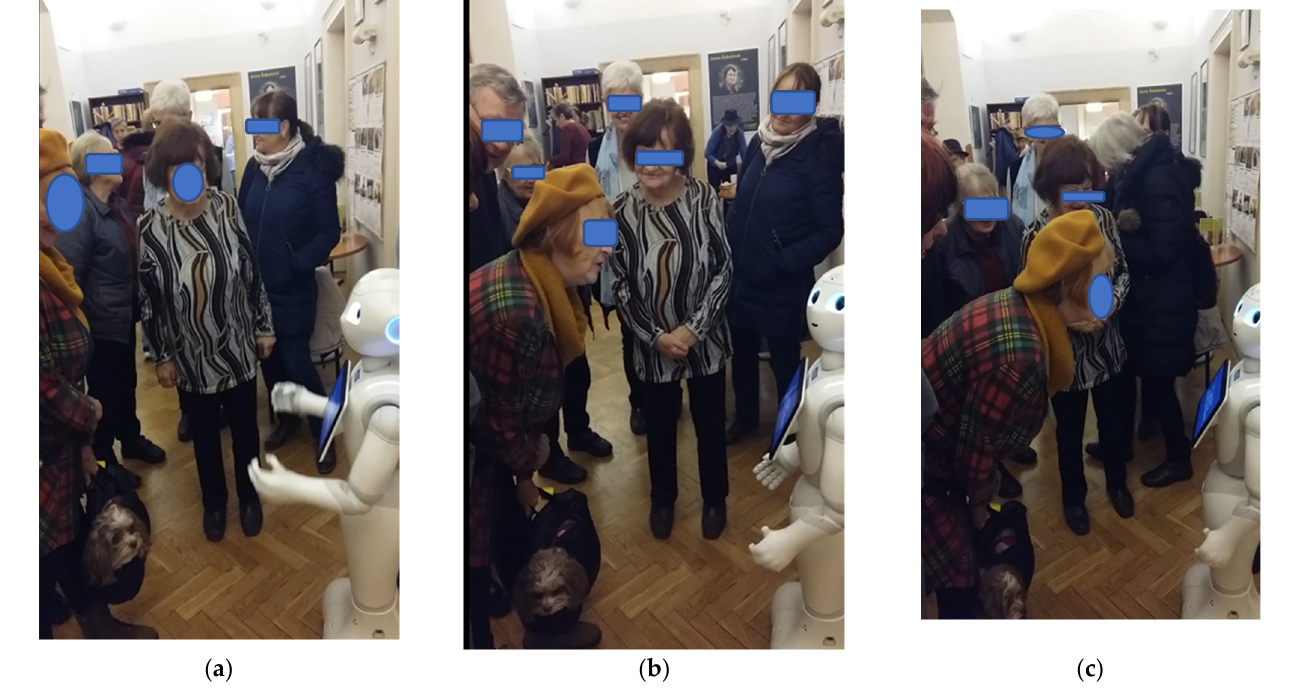
Figure 1. Talking to the robot and about the robot (in the background) ( a ). Paying attention to the human actor ( b ). Getting closer but maintaining distance ( c ). Photographer: Lucie Vidovi ć ová; photographs taken in public space with the actors’ permission.